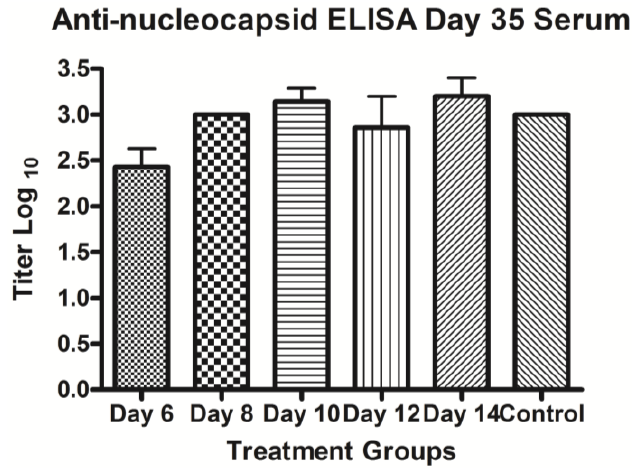
Figure 5. ELISA titers on day 35 post-ANDV infection of hamster. Titer (y-axis) is shown on Day 35 in sera collected from measurement by ELISA with antibody to the nucleocapsid protein. Various treatment and control (no treatment) groups (X-axis) are